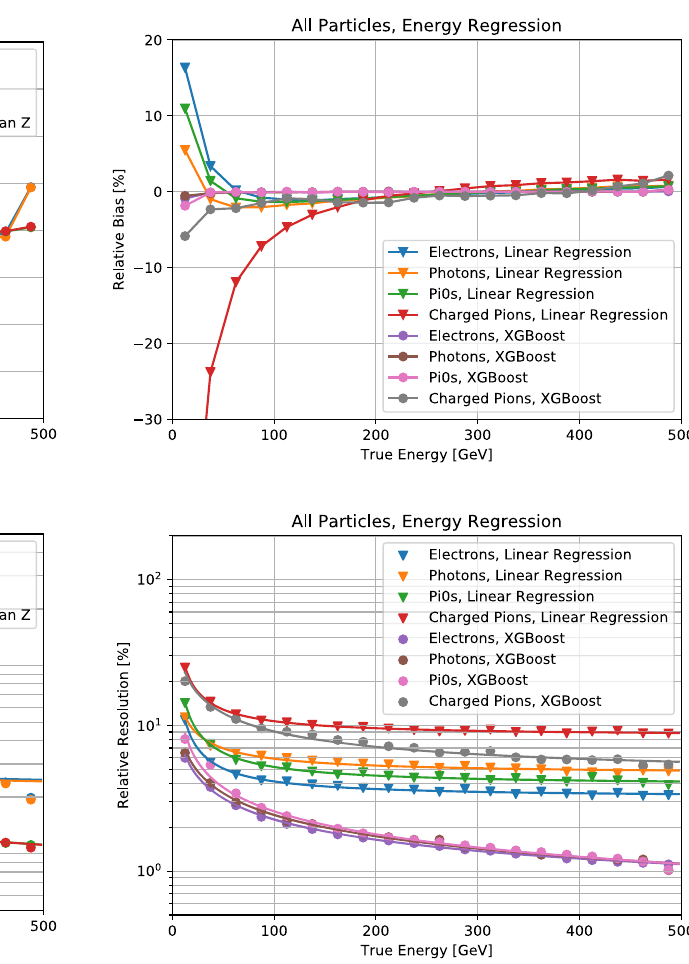
Fig. 27 Bias (top) and resolution (bottom) as a function of true energy for the XGBoost regression predictions of particle energy, using differ- ent input features for electrons